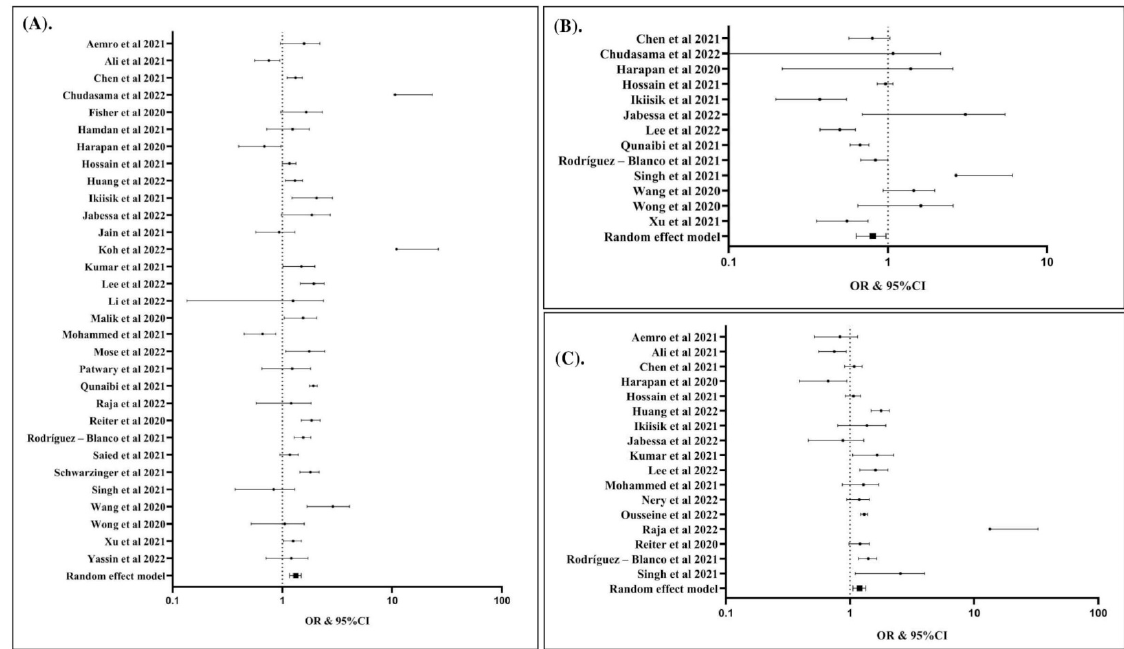
Figure 3. Female was associated with increased risk of hesitancy to COVID-19 vaccination compared to male (OR: 1.32; 95% CI: 1.17, 1.49; p Egger: 0.2840; p heterogeneity: <0.0001; p : <0.0001) ( A ). Individuals with age > 50 years was associated with lower risk of hesitancy to COVID-19 vaccination compared to individuals with age ≤ 50 years (OR: 0.79; 95% CI: 0.64, 0.98; p Egger: 0.2980; p Het: <0.0001; p : 0.0290) ( B